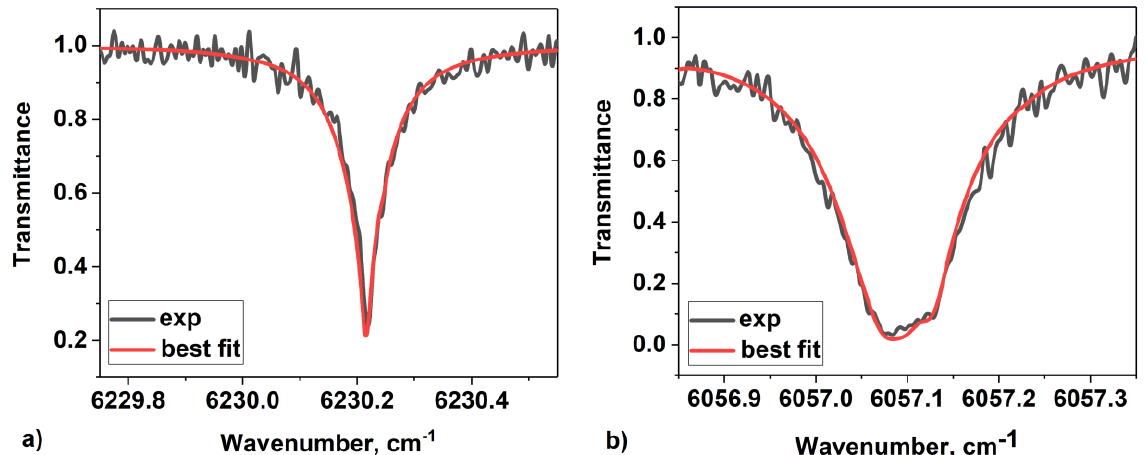
Figure 8. Spectra recorded by the ground-based MLHS prototype within one second of integration by direct Sun observation. The measured atmospheric transmission is shown by black curves, a synthetic one—by red curves. ( a ) An isolated absorption line of the CO 2 band at 1605 nm (6230 cm − 1 ), column CO 2 concentration is 401 ± 10 ppm. ( b ) A quartet of isolated CH 4 lines at 1651 nm (6057 cm − 1 ), column CH 4 concentration is 1.78 ± 0.023 ppm. (For interpretation of the references to color in this figure, the reader is referred to the web version of this article).